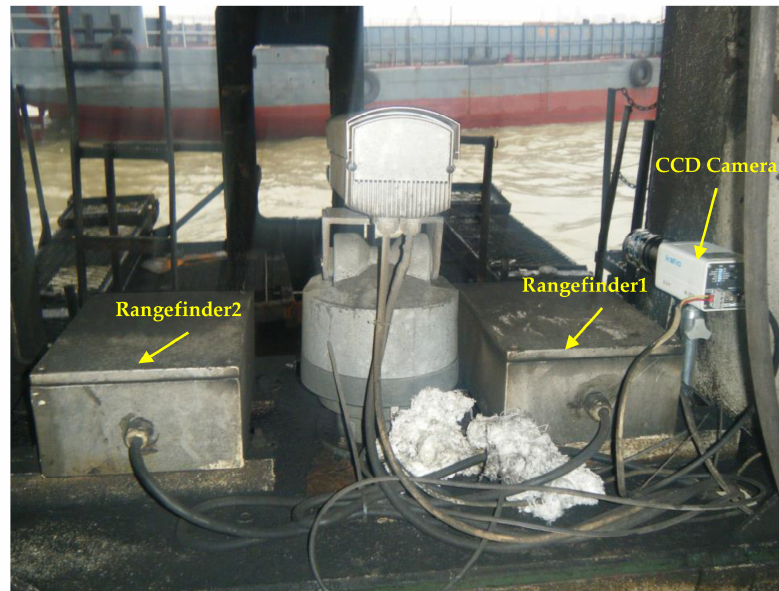
Figure 14. Rangefinders and CCD camera installed on the ship’s deck.